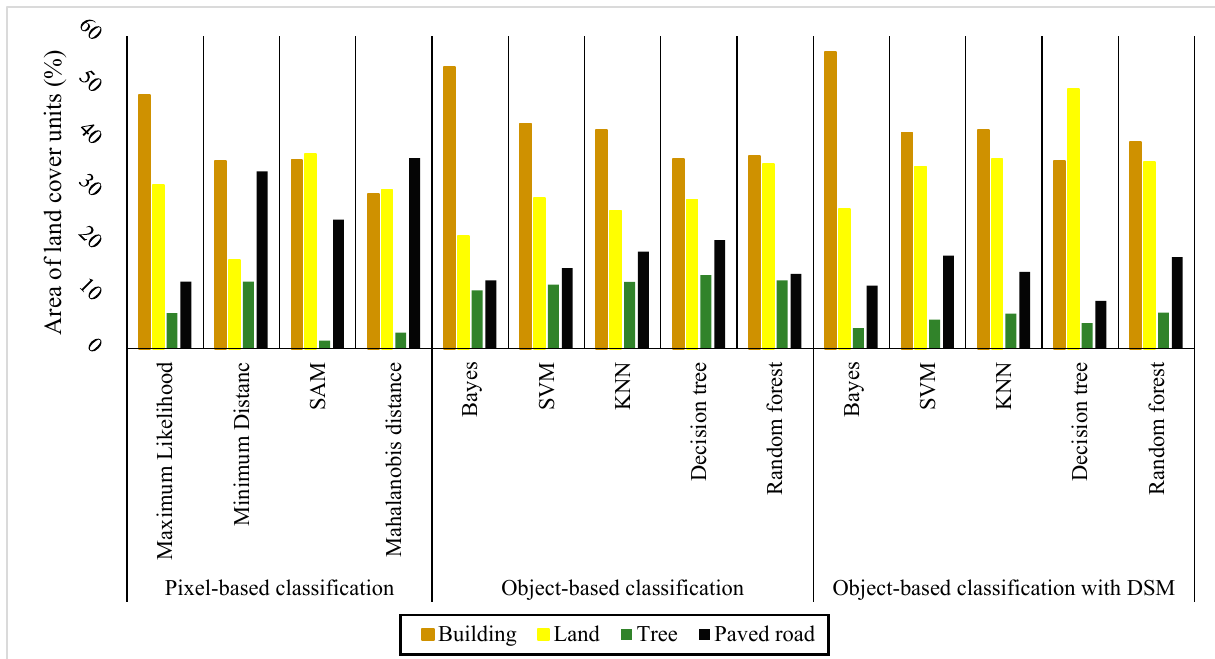
Figure 4. Percentage area of different land cover units (buildings, barren land, trees, roads) identified when using pixel-based, object-based and object-based with digital elevation model (DSM) methods to classify unmanned aerial vehicle (UAV) images.